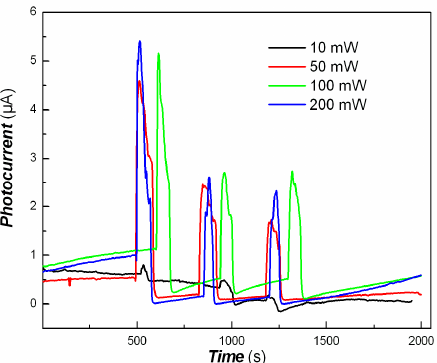
Figure 13. Photo-responses of Au/PANi nanocomposites functionalized with beta-cyclodextrin to 10, 50, 100, and 200 mW 808 nm NIR (Sample 2–chloroauric acid (50 mL)).